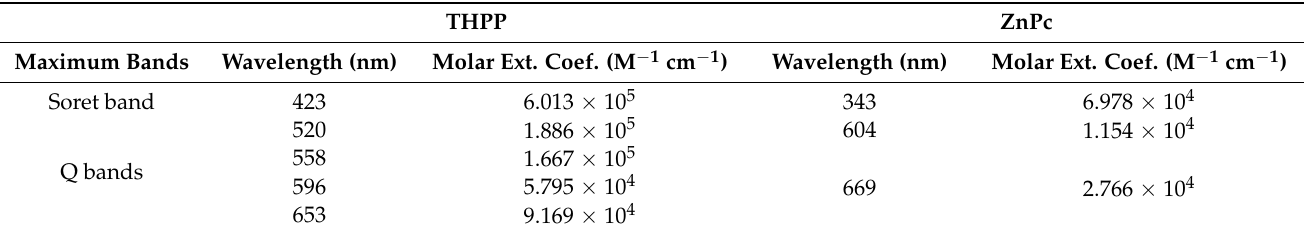
Figure 3. Absorption spectra of ( a ) THPP in DMF solution (4.1 × 10 − 7 mol L − 1 to 3.3 × 10 − 6 mol L − 1 ), ( b ) ZnPc in DMF solution (4.8 × 10 − 6 mol L − 1 to 6.4 × 10 − 5 mol L − 1 ), ( c ) PPc blend before and after film formation, ( d ) magnified spectra of the PPc blend in the range 500–800 nm. Table 2. Molar extinction coefficient at different wavelengths of THPP and ZnPc in DMF solution within concentration range 1.6 × 10 − 6 mol · cm − 1 to 6.4 × 10 − 5 mol · cm − 1